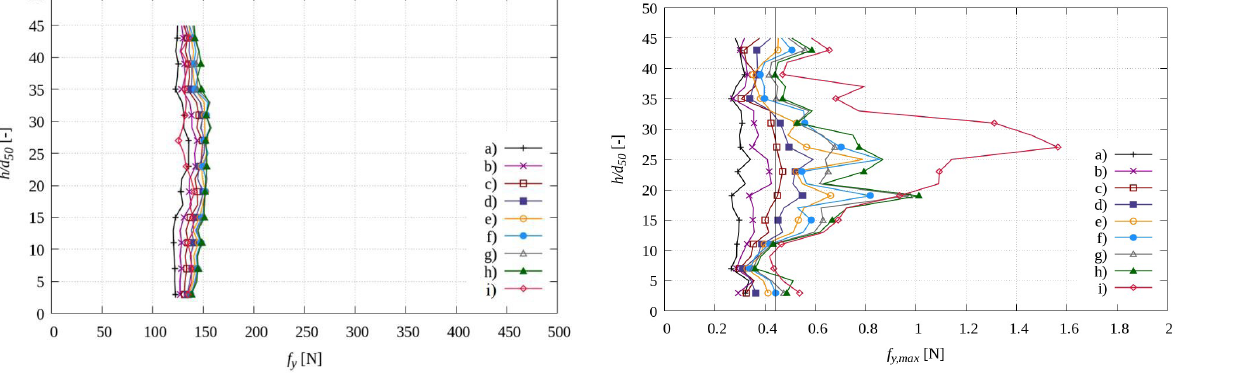
Figure 27: Distribution of the normal forces f across the normalized specimen height h / d centre for: a) u u = 1.00 mm, e) u x u = 2.00 mm and i) u x d = 0.5 mm). 50